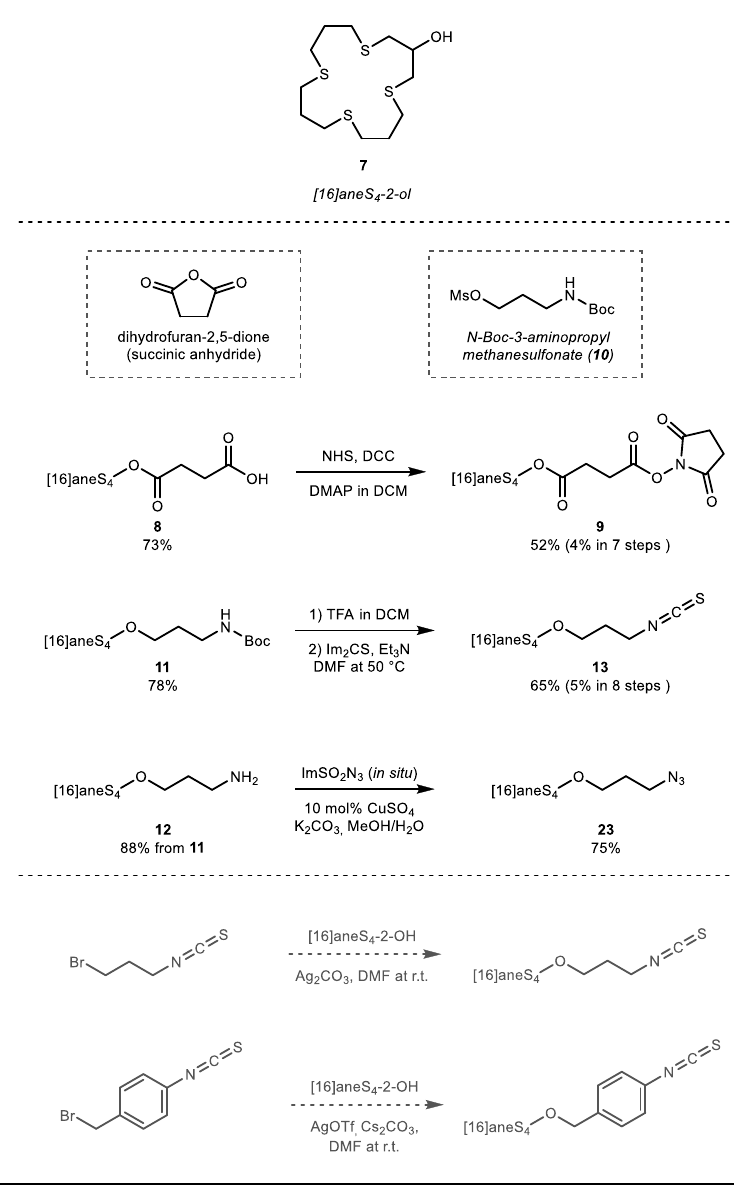
Figure 3. Synthesis of bifunctional [16]aneS4 chelator derivatives, including the NHS ester, isothio- cyanate and azide derivative.